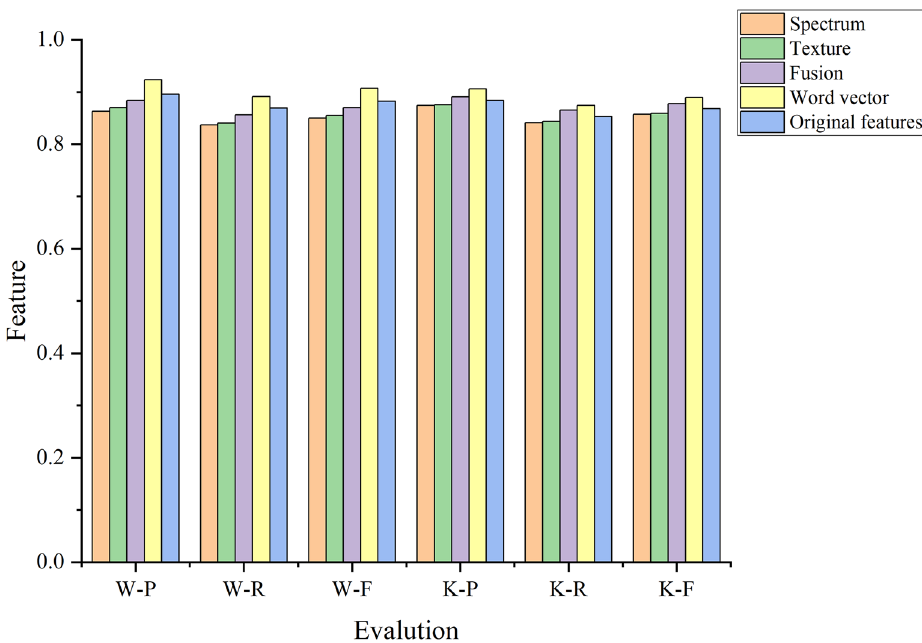
Figure 9. Labelling results of the proposed annotation strategy and a conventional pixel-by-pixel annotation